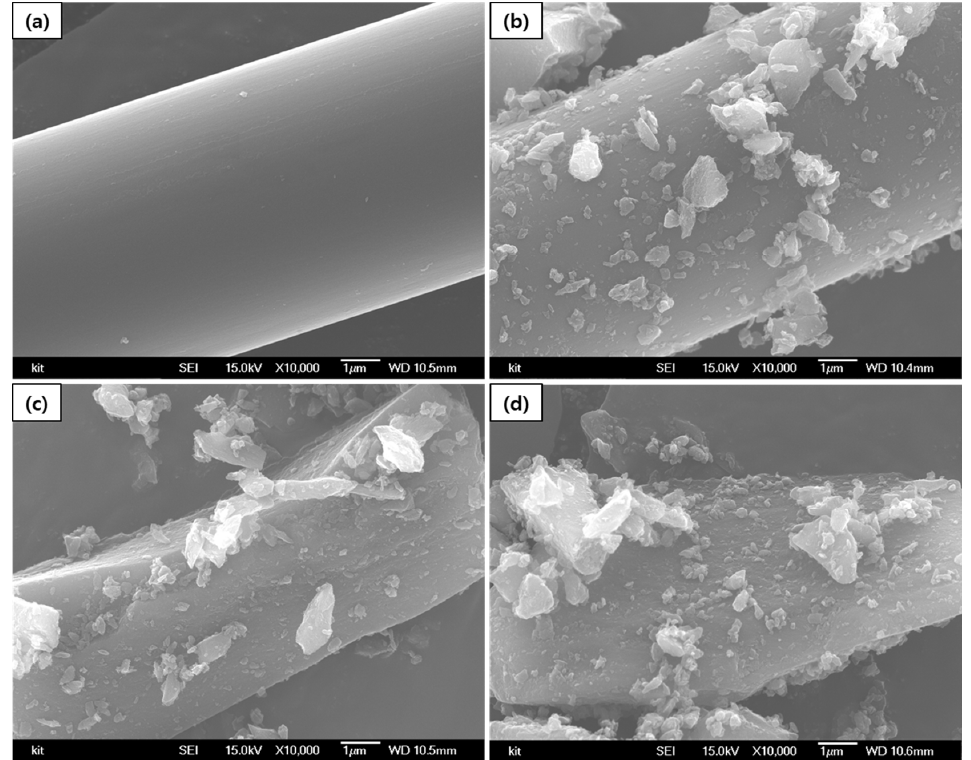
Figure 2. SEM images of mPCFs (×10,000). ( a ) Desized carbon fiber and ball milling times of ( b ) 6 h, ( c ) 12 h, and ( d ) 18 h.